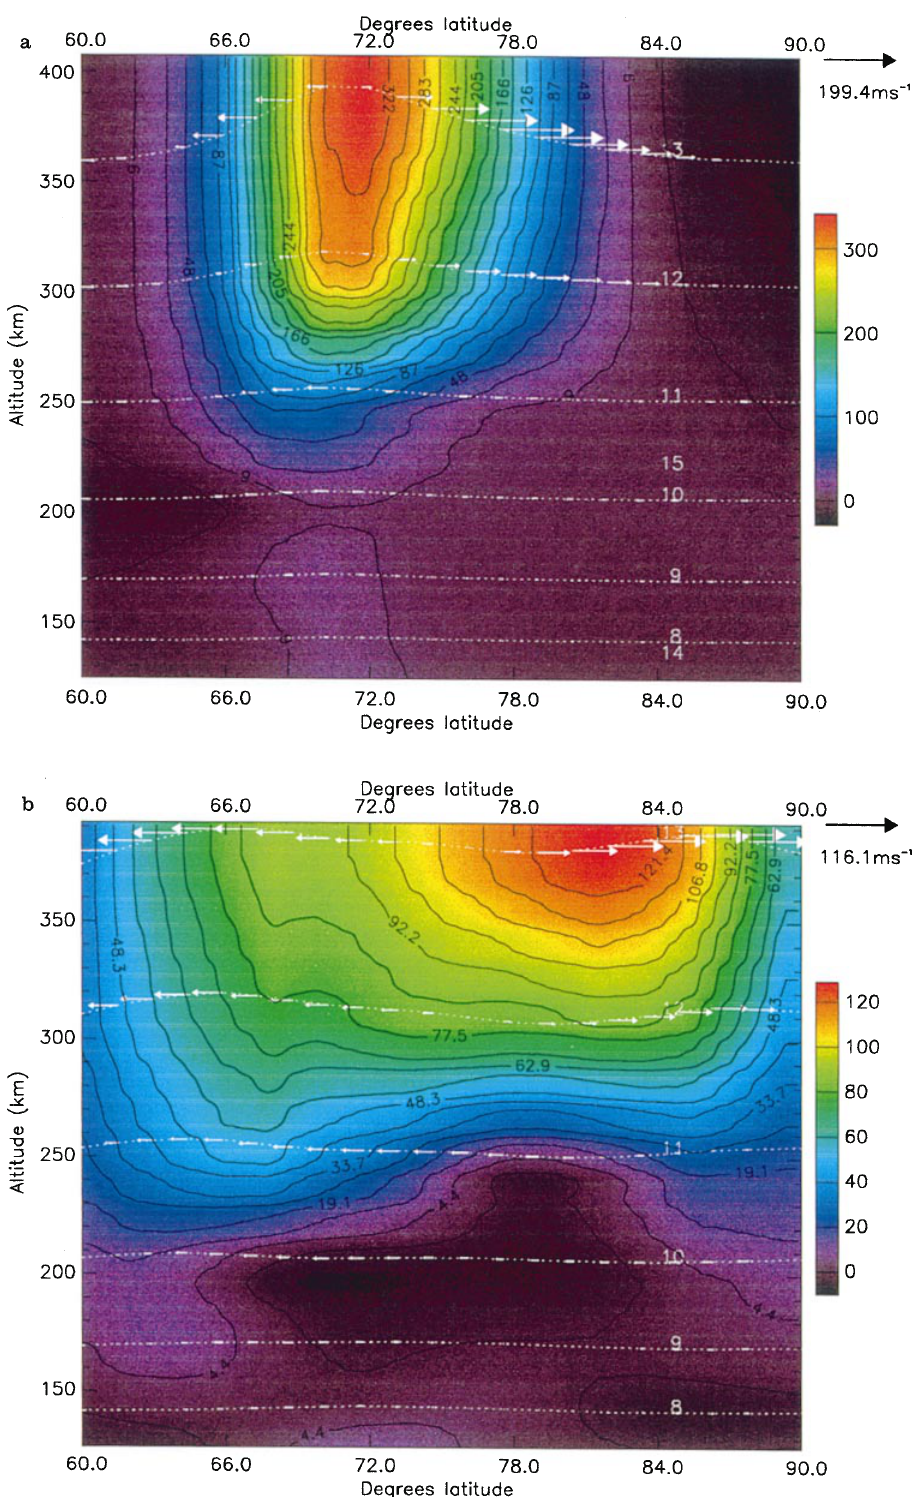
Fig. 4a, b. Altitude/100 (cid:14) W me- ridian cross section plot of neutral temperature perturbations at a 1927 UT and b 1942 UT. The colour scales for each are di(cid:128)erent and are shown by the colour bar to the right of each (values in K). Dotted lines show the perturba- tions in the heights of the fixed pressure levels multiplied by fac- tors of a 1 and b 3 and each o(cid:128)set by their mean height. Plotted vectors show the perturbation in the meridional